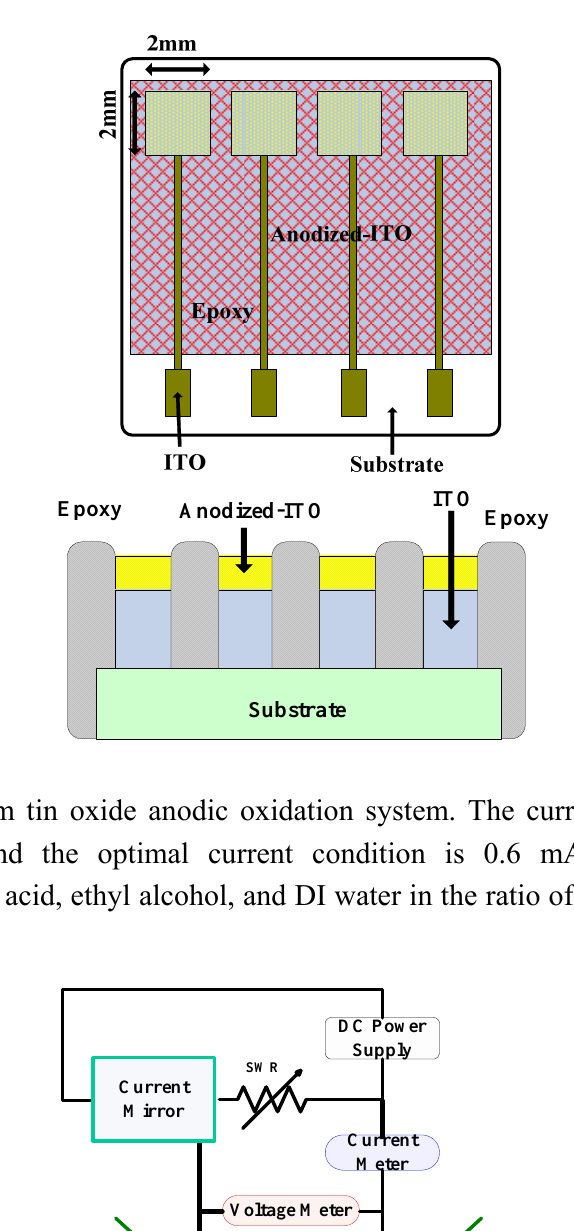
Figure 1. Planar view and cross section of anodized-ITO pH electrode.